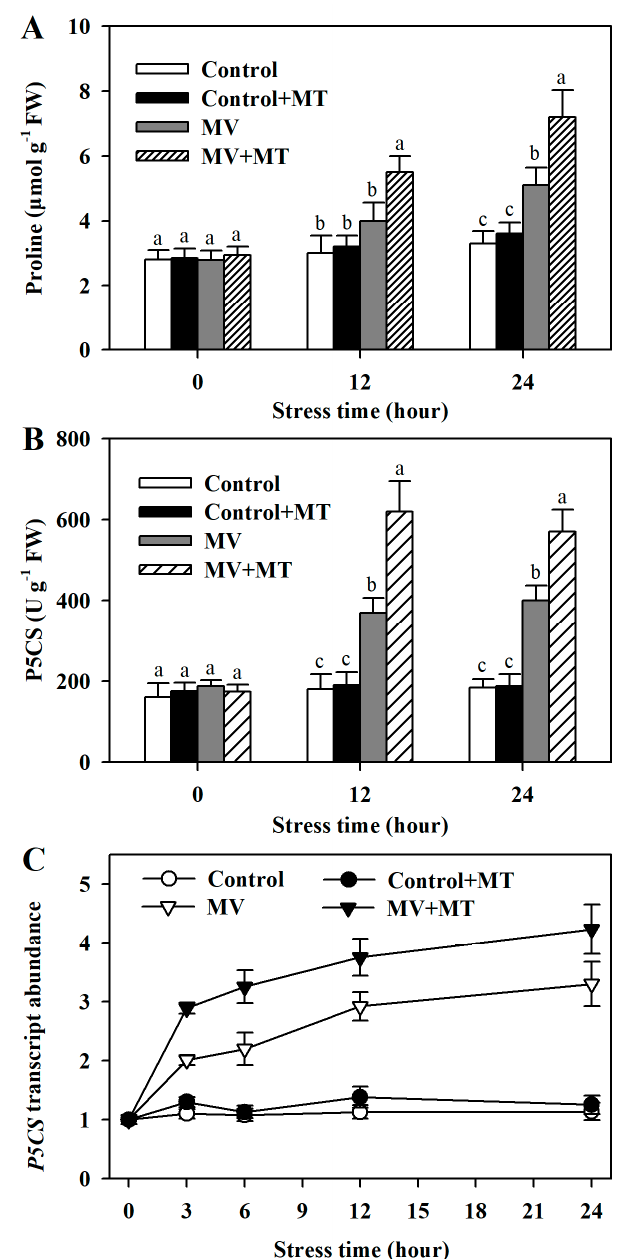
Figure 6. ( A ) Proline accumulation; ( B ) P5CS activity; ( C ) P5CS mRNA abundance as affected by melatonin in poplar leaf discs under MV stress. Poplar leaf discs were pretreated with 150 μ M melatonin in the dark for 12 h, and then, leaf discs were exposed to 50 μ M methyl viologen in the light for 24 h. The values presented are means ± SDs ( n = 3). Different letters indicate significant difference at p < 0.05 among treatments.